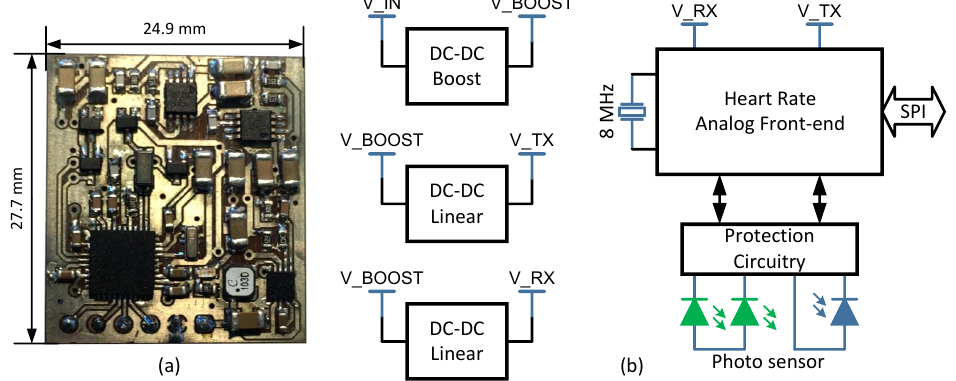
Figure 1. ( a ) Photoplethysmogram sensor, and ( b ) major building blocks: analog front-end, power rails, clock, and protection circuitry. DC: direct current; SPI: serial peripheral